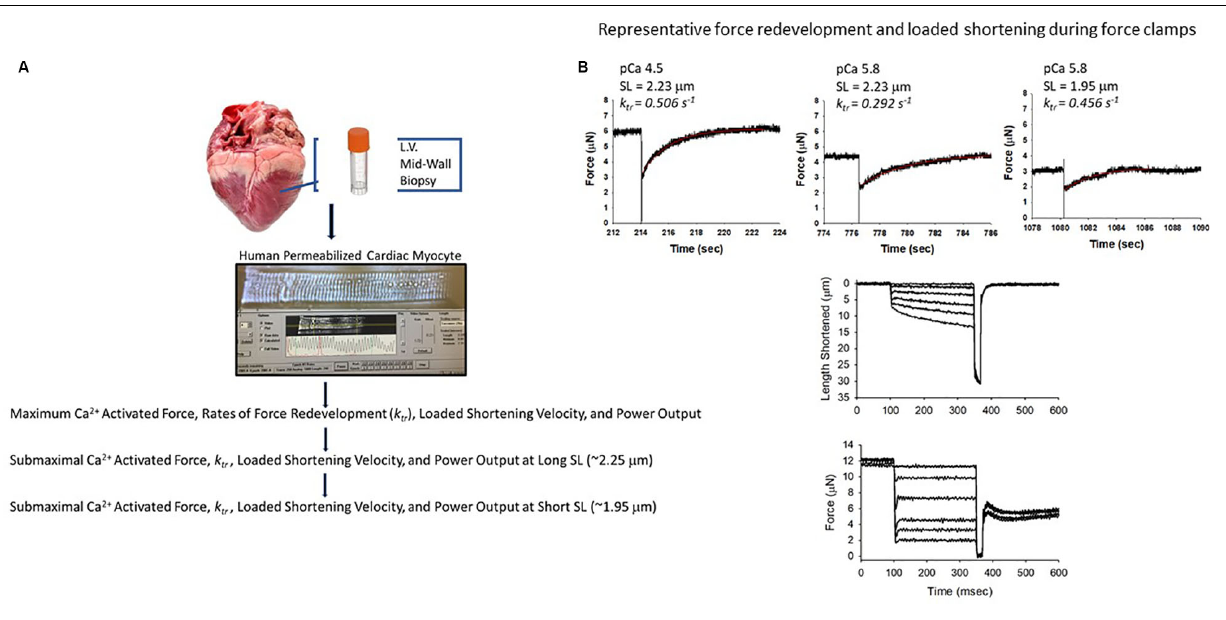
FIGURE 1 | Experimental design. (A) Tissue was procured as part of the University of Kentucky Heart Transplant program and Biobank program. Mid-wall myocardial samples of distal anterior left ventricular free wall were dissected and snap frozen in liquid nitrogen and stored at -150 ◦ C before shipping to the University of Missouri. Single human permeabilized cardiac myocyte preparations were mounted between a force transducer and a motor, and contractile properties were measured during maximal and sub-maximal Ca 2 + activations at long ( ∼ 2.25 µ m) and short sarcomere lengths ( ∼ 1.95 µ m). (B) Representative force redevelopment and loaded shortening traces from a human permeabilized cardiac myocyte